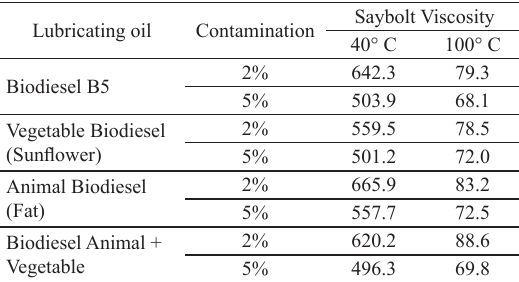
Table 3. Saybolt Viscosity Values for Each Contamination